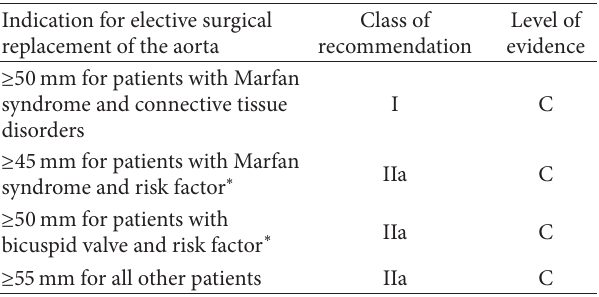
Table 1: Recommended indications for elective replacement of the